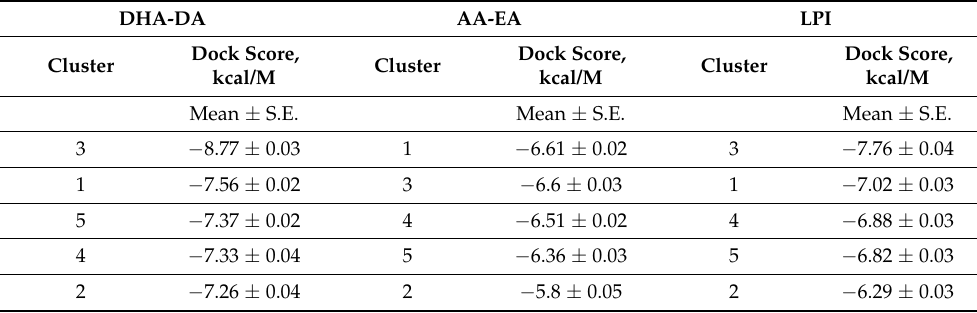
Table 2. Calculated binding energies of anandamide (AA-EA), N -docosahexaenoyl dopamine (DHA- DA), and lysophosphatydyl inositol (LPI) for the calculated alternate DHA-DA binding clusters of GPR55 molecule, molecular docking results (AutoDock Vina); the lower energy corresponds to a higher affinity, mean ± S.E., n = 5